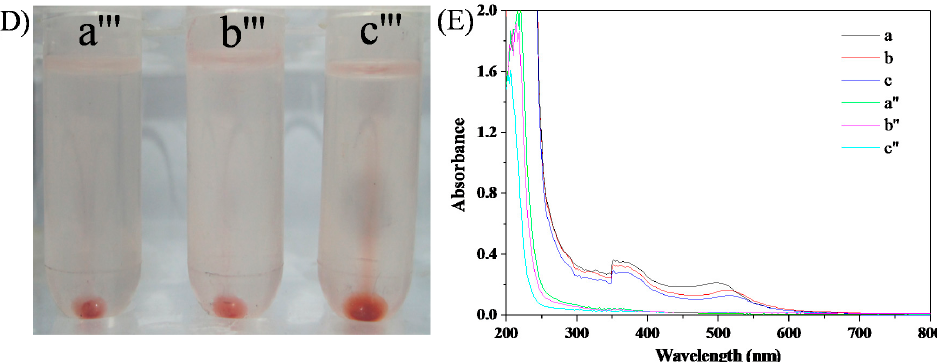
Figure 11. Colorimetric detection and separation of Ag + in drinking water: ( A ) photographs of 0.49 nM HPEI-IBAm-AuNPs solution with (a) 60 µM, (b) 90 µM, and (c) 120 µM of Ag + ; ( B , C ) represent